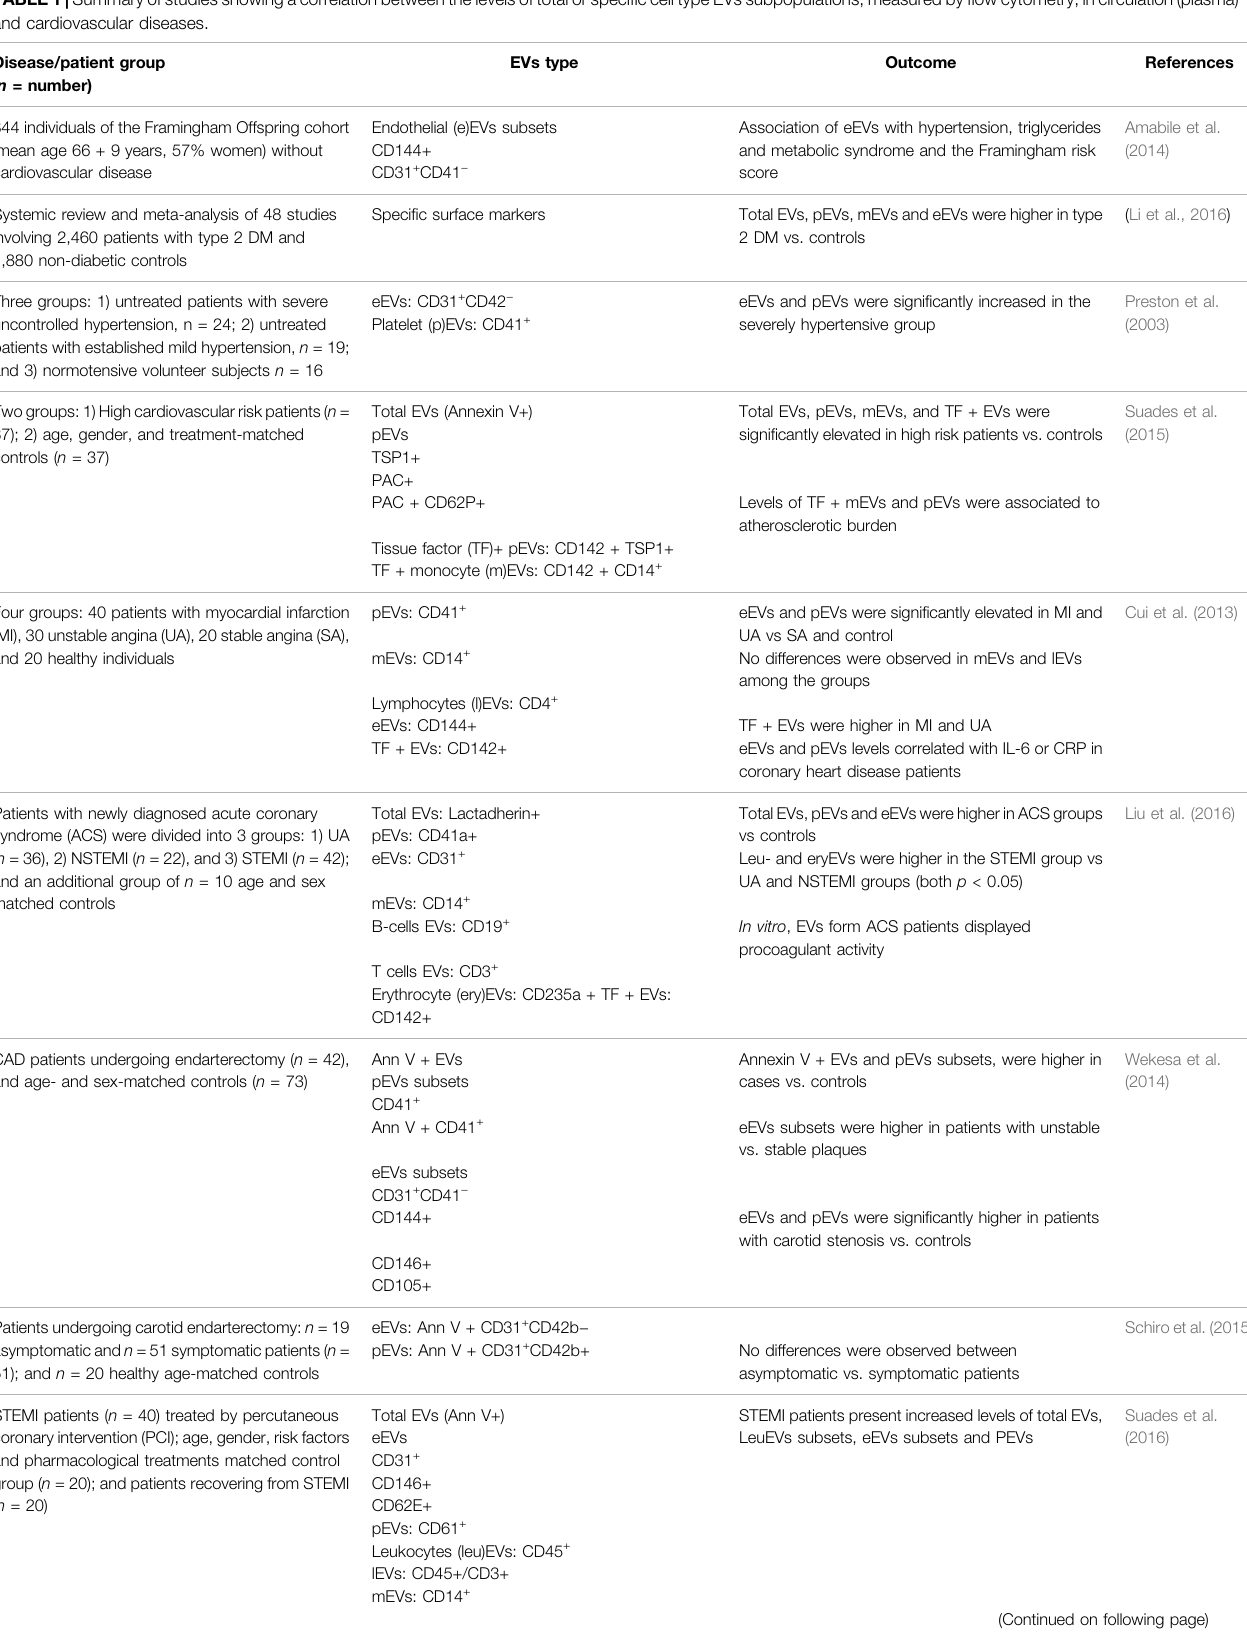
TABLE1| Summaryofstudiesshowingacorrelation betweenthelevelsoftotalorspeci fi ccelltypeEVssubpopulations, measuredby fl owcytometry,incirculation(plasma) and cardiovascular diseases. Disease/patient group ( n =